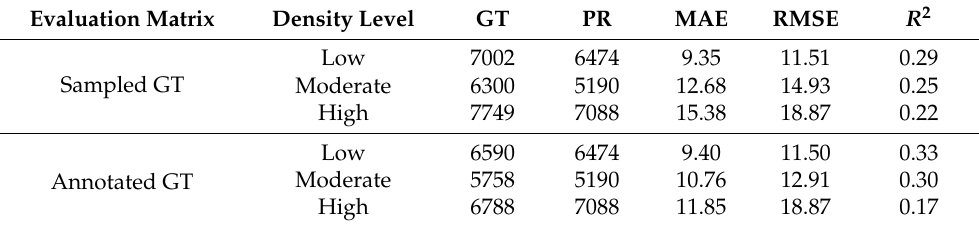
Table 5. The model performance on different density